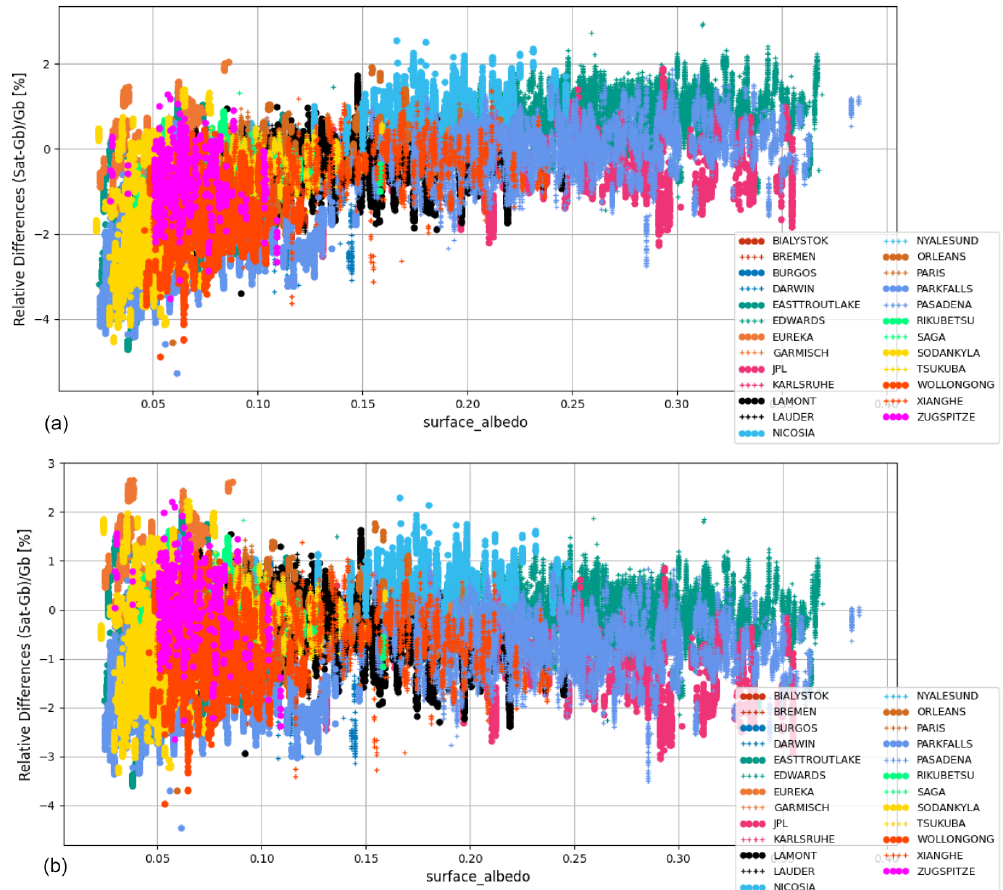
Figure 2. Relative biases between co-located S5P (standard XCH 4 product – a ; bias-corrected XCH 4 product – b ) and TCCON XCH 4 data with a priori alignment are plotted as a function of the surface albedo retrieved by S5P at 25 TCCON stations within the period between November 2017 and September 2020. Spatial co-location with radius of 100km and time of ± 1h around the satellite overpass were